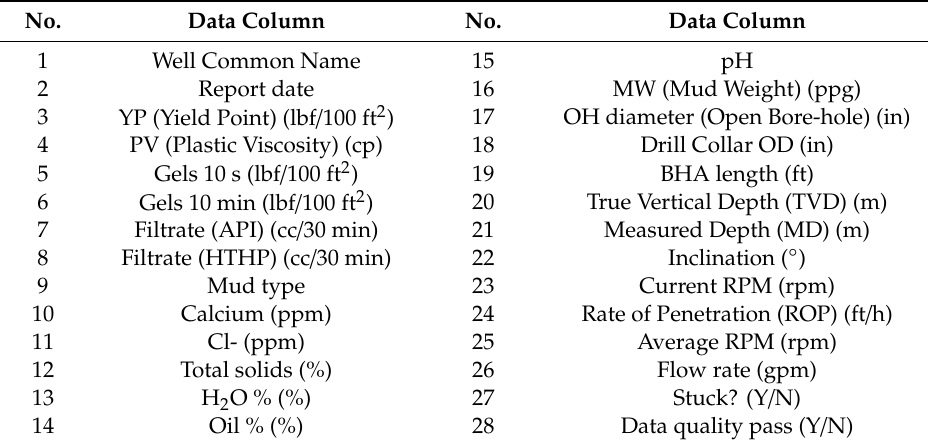
Table 2. Drilling parameters recorded in the master